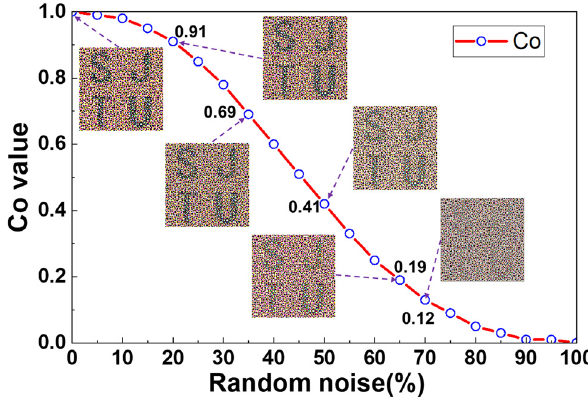
Figure 8: Noise analysis of SSPE